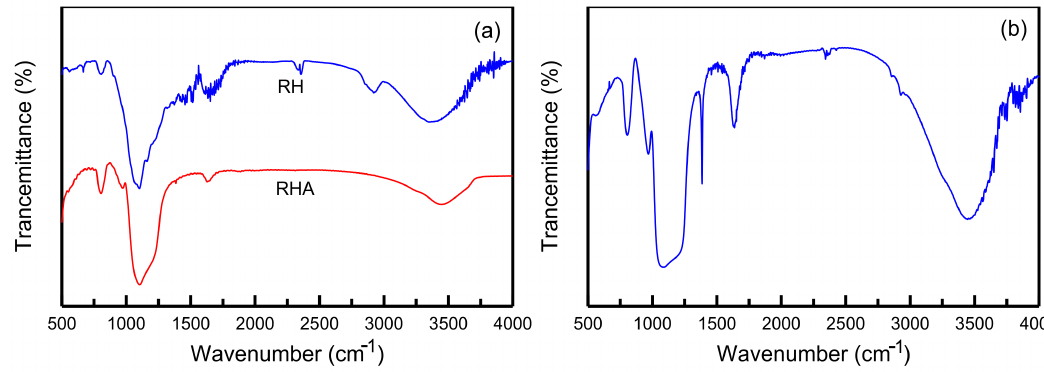
Figure 2. FTIR spectra: ( a ) RH and RHA, and ( b )